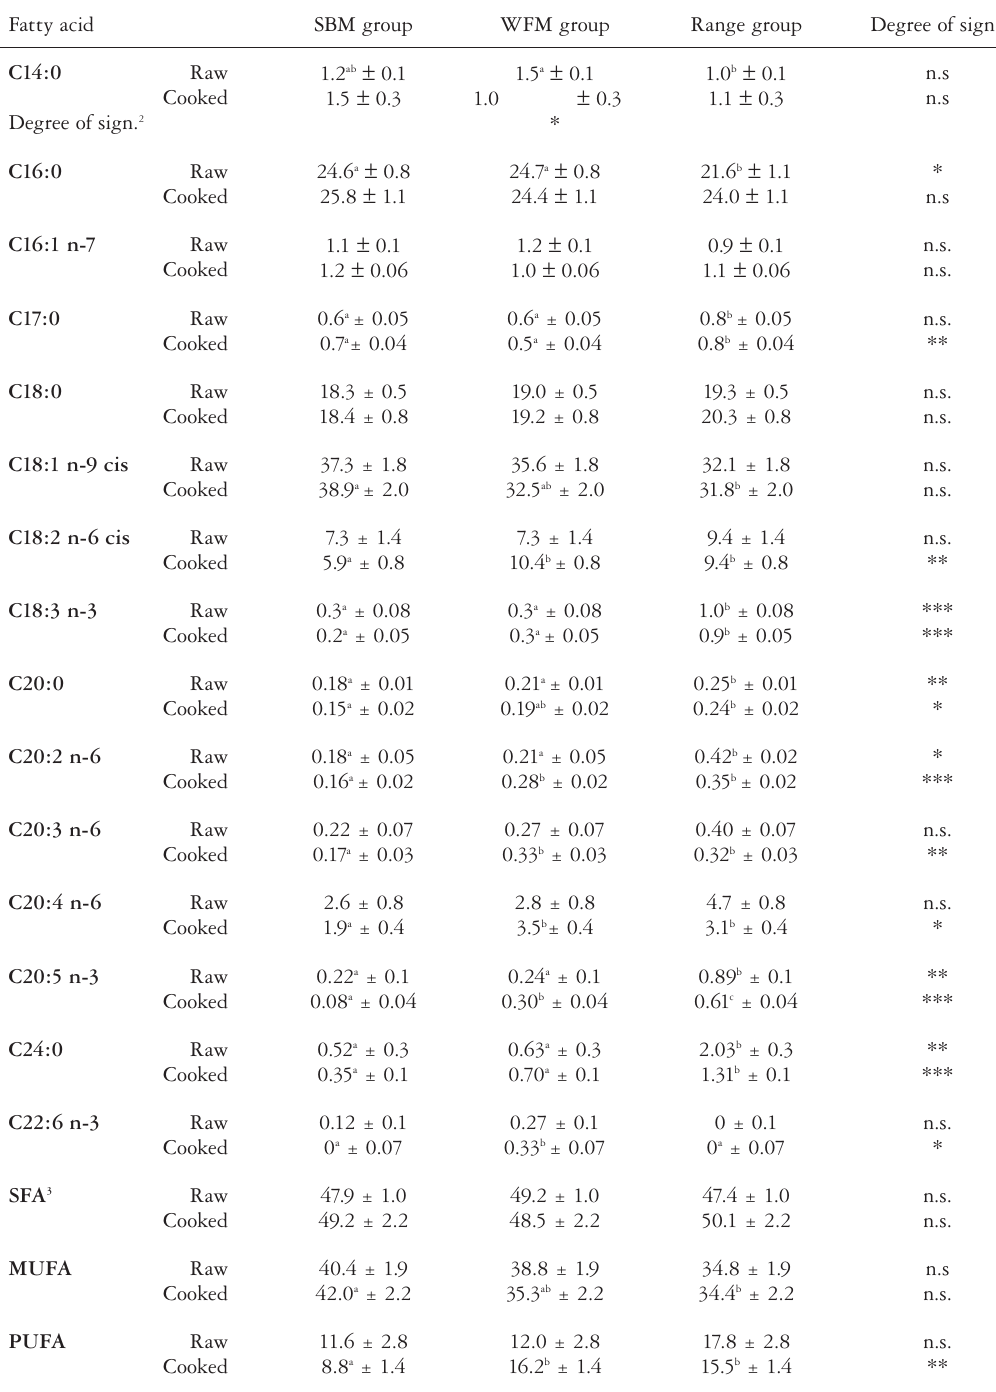
Table 7. Fatty acid composition (% of total identified fatty acids) of raw and cooked M. longissimus (LD) in reindeer from three different feeding treatments; SBM (feed mixture based on soybean meal protein; n =4), WFM (feed mix- ture based on fish meal protein; n =4) and grazing free ranging animals ( n =4) included in the study (least- squares means and standard